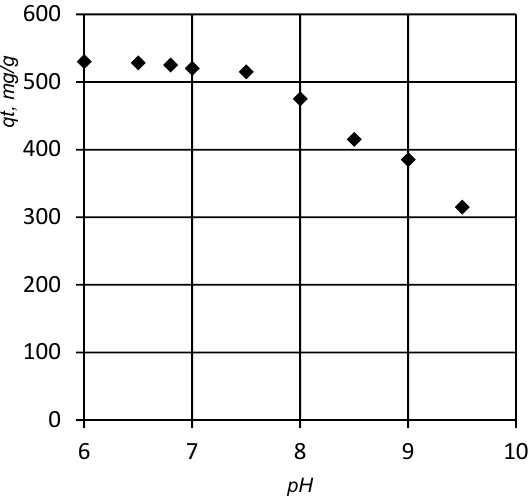
Figure 11. Influence of pH on diazepam sorption by natural Na-montmorillonite; T = 37.0 ± 0.1 °C; Ci = 18mg/L; and S:L ratio = 1 g/L.